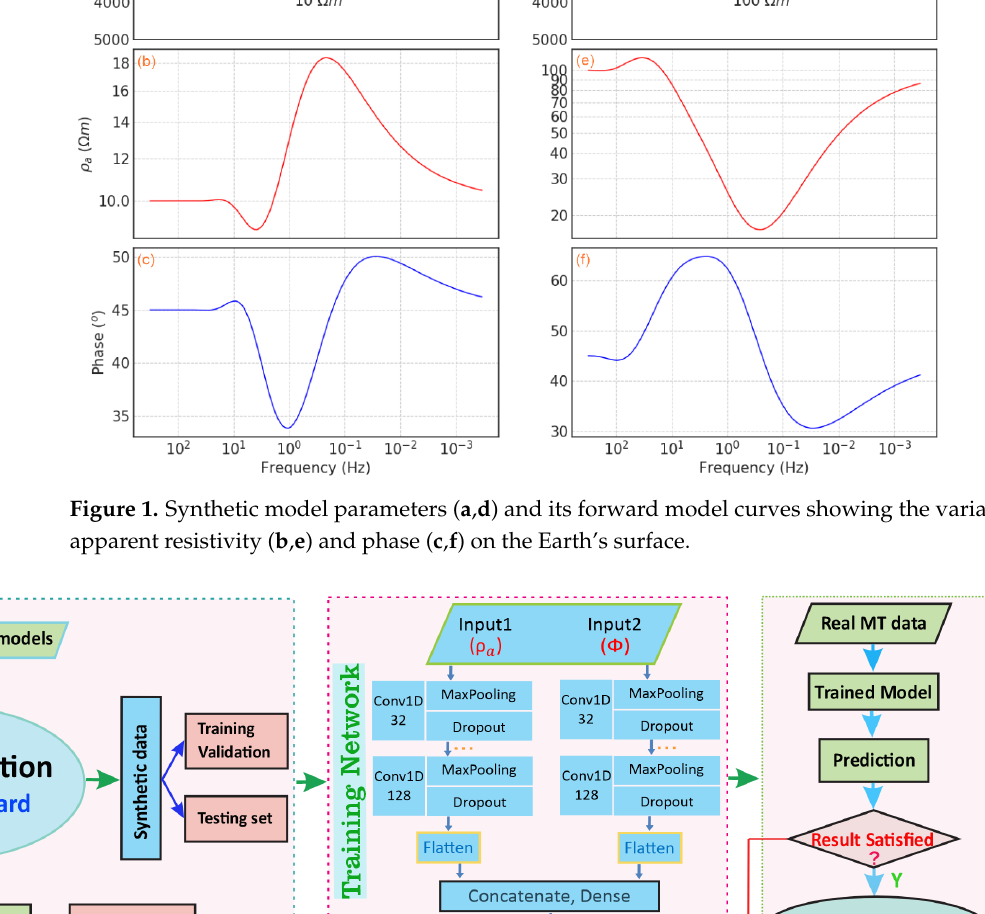
Figure 1. Synthetic model parameters ( a , d ) and its forward model curves showing the variation of apparent resistivity ( b , e ) and phase ( c , f ) on the Earth’s surface.